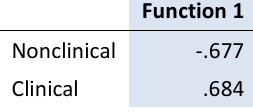
Table 4: Group centroids on the discriminant